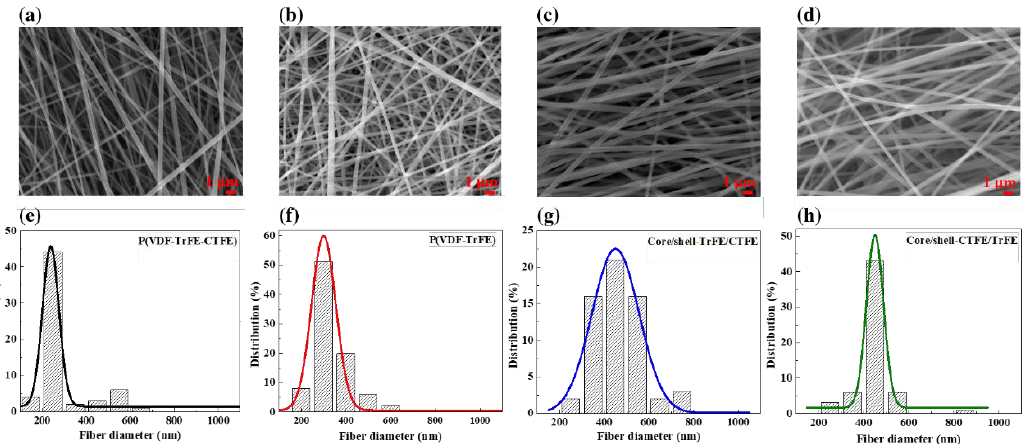
Figure 1. SEM images of the ( a ) pristine P(VDF-TrFE-CTFE), ( b ) pristine P(VDF-TrFE), ( c ) core/shell-TrFE/CTFE, and ( d ) core/shell-CTFE/TrFE nanofibers. The distribution of electrospun nanofibers in the ( e ) pristine P(VDF-TrFE-CTFE), ( f ) pristine P(VDF-TrFE), ( g ) core/shell-TrFE/CTFE, and ( h ) core/shell-CTFE/TrFE films.